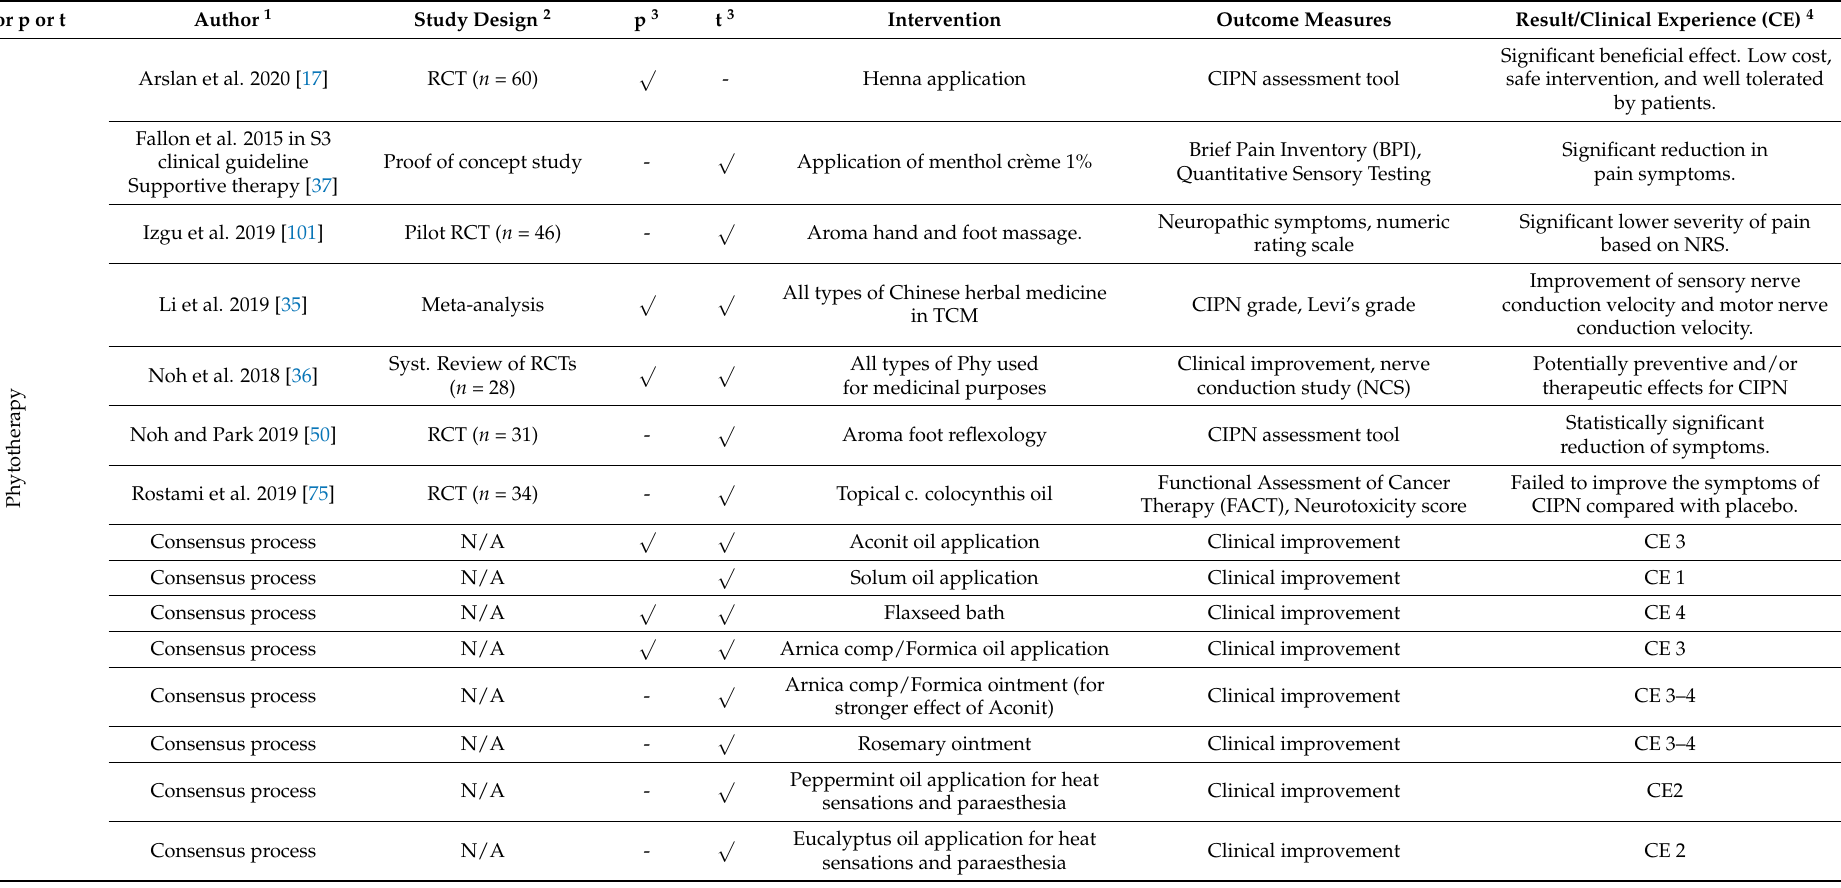
Table 1. Summary of studies and results of consensus process regarding the options (O) for prevention (p) or/and treatment (t) of